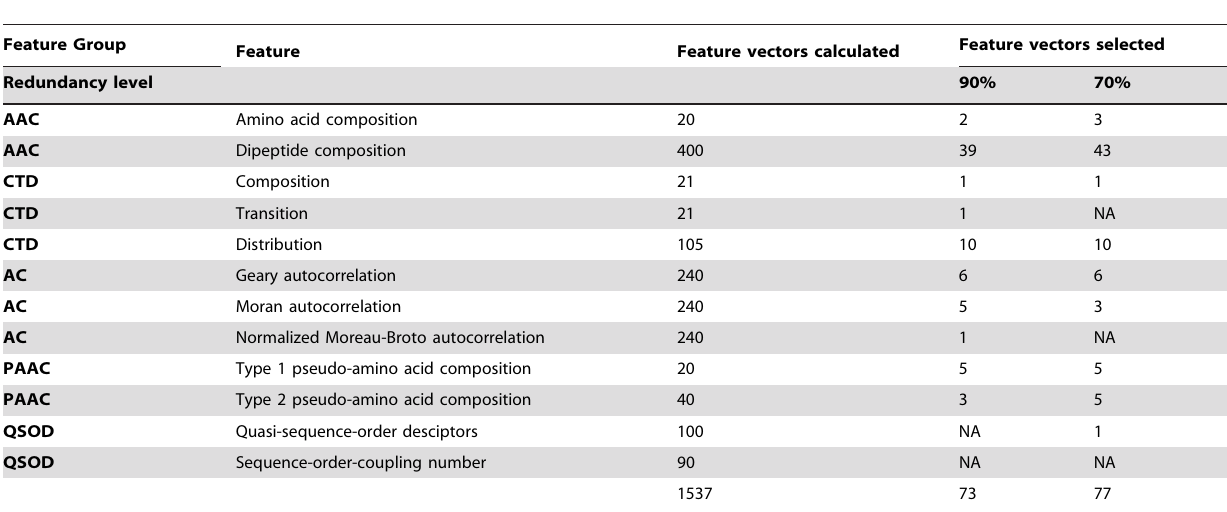
Table 3. Feature distribution of optimal feature subset generated by correlation based feature selection.